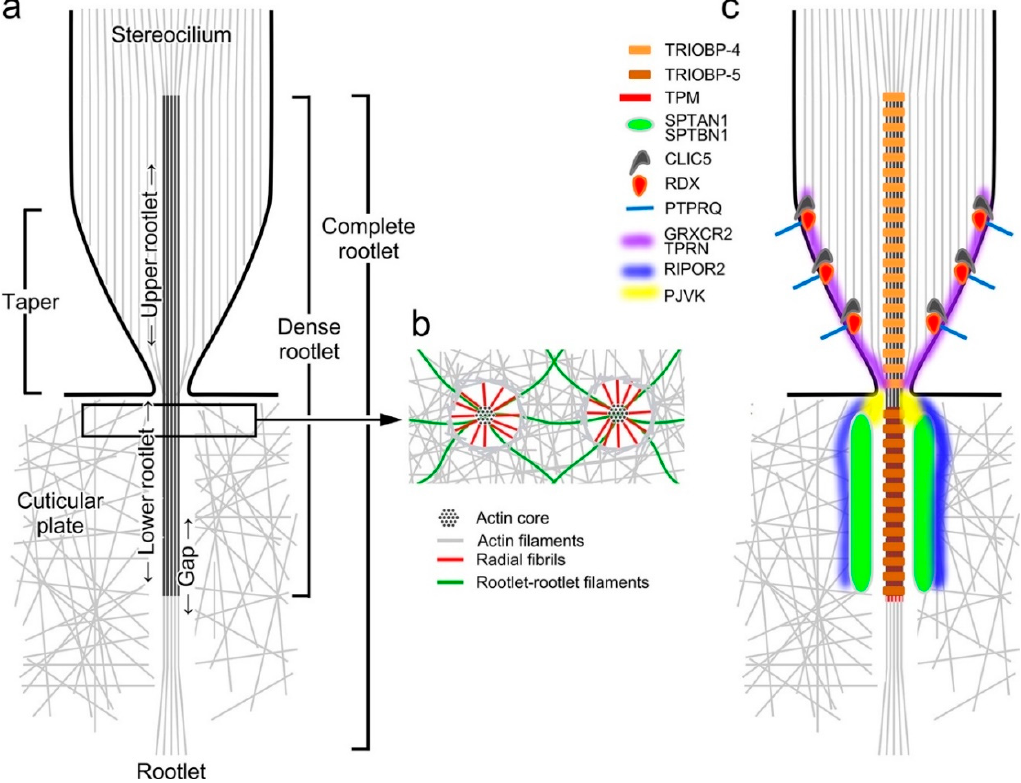
Figure 2. Diagrams illustrating rootlet structure. ( a ) Actin filament structure only. In a stereocilium, spacing of actin filaments (gray) is maintained by actin–actin crosslinkers (not shown). Crosslinkers disappear in the taper region, where most filaments terminate on or near the plasma membrane in a systematic way, forming the taper. By contrast, the central dozen or two filaments are gathered together to form the rootlet, which eventually penetrates into the cell and extends into the cuticular plate. The rootlet stains darkly with osmium tetraoxide, forming the dense rootlet, which accounts for the majority of the rootlet visible in TEM. Rootlets have an upper portion in the stereocilium (‘upper rootlet’) and a lower portion in the cuticular plate (‘lower rootlet’). In the cuticular plate, there is a gap between the filaments of the rootlet and the meshwork of the cuticular plate. ( b ) Rootlet connecting filaments. In cross-sections of the rootlet near the apical surface (see box in a ), several types of filaments can be identified. Radial fibrils (red) extend from the core of the rootlet to the surrounding cuticular plate, while rootlet–rootlet filaments, visible only after detergent and EDTA extraction prior to fixation, appear to interconnect rootlets. ( c ) Proteins of the rootlet. TRIOBP-4 is exclusively associated with the upper rootlet, while TRIOBP-5 is associated with the lower rootlet. Both TRIOBP splice forms have multiple actin binding domains, which apparently allow TRIOBP to wrap around and bundle the rootlet filaments. TRIOBP-5 has additional domains (separately encoded by the TRIOBP-1 splice form) that may connect TRIOBP-5 to surrounding structures. The spectrin isoforms SPTAN1 and SPTBN1 apparently form a sheath around the lower rootlet, appearing as rings in confocal horizontal sections. CLIC5, RDX, and PTPRQ form a membrane complex in the taper region; they may also bind TPRN, which is also associated with the taper and rootlet. GRXCR2 maintains TPRN in the taper region. The precise localization of PJVK is not clear. RIPOR2 (FAM65B) also forms rings around the rootlet, but it is unclear whether the rings persist along the lower portion of the rootlet.